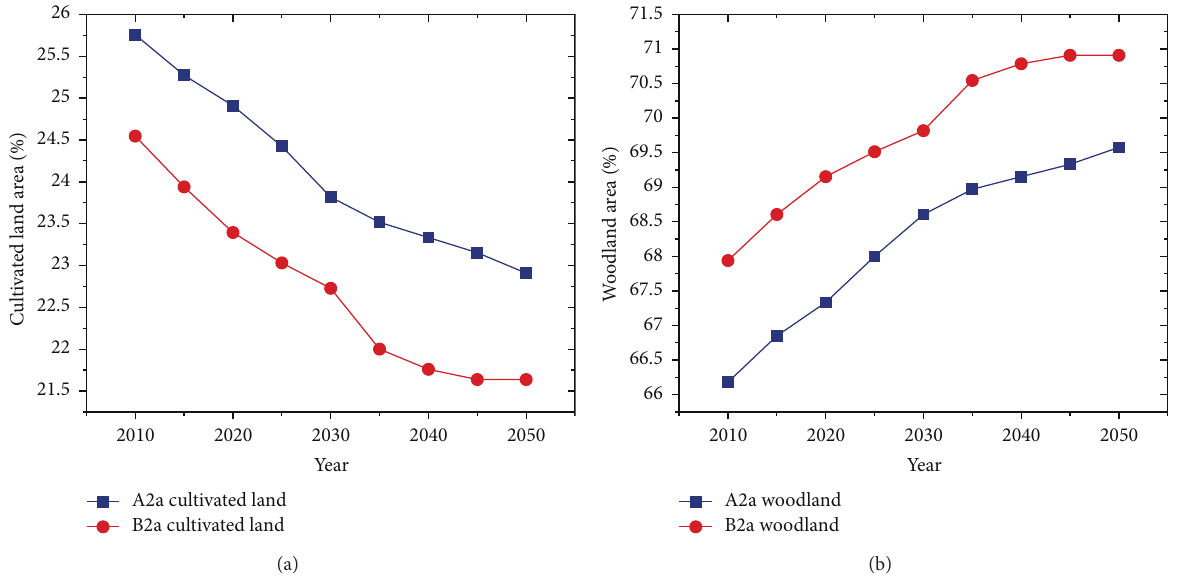
Figure 3: Interannual change of cultivated land and woodland area percentage in the next 40 years under A2a and B2a land cover change scenarios.